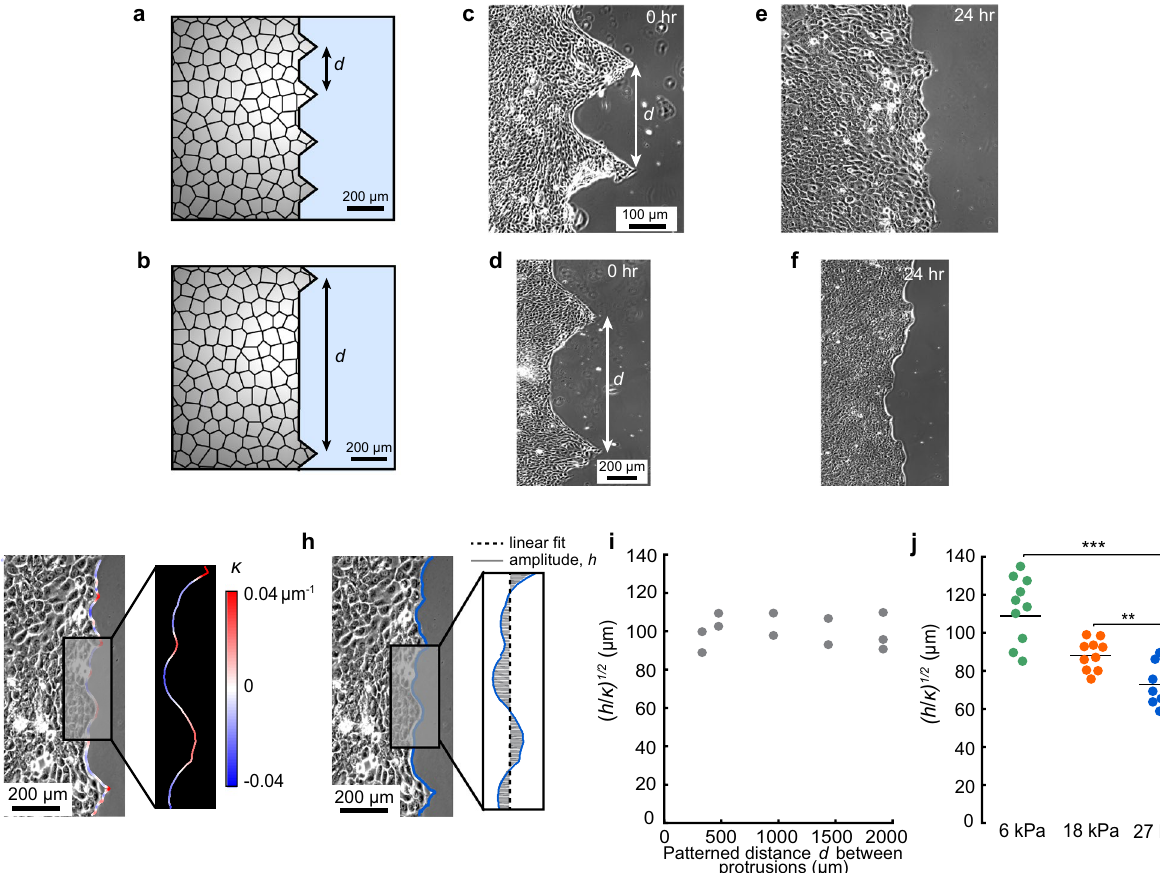
Figure 4. Micropatterning of cell features with varied spacing and quantification of √ h /κ at leading edge. ( a , b ) Schematic of cell layer having patterned distance, d , of 250 μm ( a ) and 1000 µm ( b ) between protrusions. ( c , d ) Representative phase contrast images of HaCaTs patterned with d = 250 μm (c) and d = 1000 µm ( d ) immediately after barrier removal. ( e , f ) Representative phase contrast images of HaCaTs patterned with d = 250 μm ( e ) and d = 1000 µm ( f ) at 24 h after barrier removal. ( g ) Representative phase-contrast image of leading edge of cell layer after 24 h of migration. The local curvature, κ, at the leading edge is overlaid on the phase contrast image in color. ( h ) Representative phase-contrast image of leading edge. The linear fit and the amplitude, h , of the leading edge are shown where the amplitude is the orthogonal distance from the linear fit to the leading edge. ( i ) The metric √ h /κ of the leading edge after 24 h of migration, which is predicted to be proportional to λ , is plotted against the initial patterned distance d between protrusions. ( j ) √ h /κ after 24 h of migration for cells seeded against a barrier with a flat edge on substrates of varied stiffness. Each data point represents an independent measurement. Horizontal lines indicate